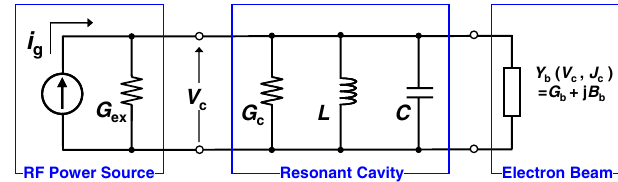
FIG. 1. Equivalent circuit of an rf gun consists of an rf power source, a resonant cavity, and a beam loading